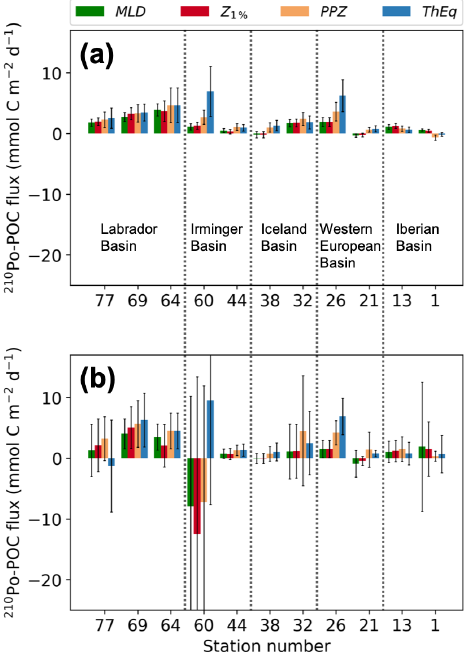
Figure 7. POC fluxes derived from 210 Po for the mixed-layer depth (MLD), the base of the euphotic zone ( Z 1% ) , the base of the pri- mary production zone (PPZ), and the 234 Th- 238 U equilibrium depth (ThEq). (a) POC fluxes derived from the 210 Po fluxes that were cal- culated from the deficit alone; (b) POC fluxes derived from the sum of the 210 Po fluxes that were calculated from the 210 Po deficit and vertical advective flux. Note that the >1µm particles were used to calculate the POC / 210 Po ratios. The stations were plotted from west to east.